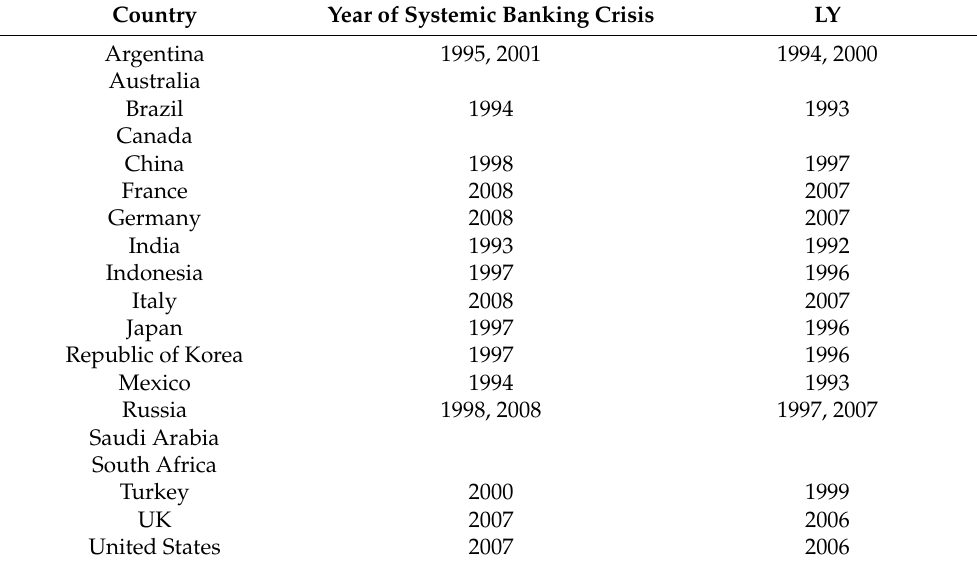
Table 1. Year of the systemic banking